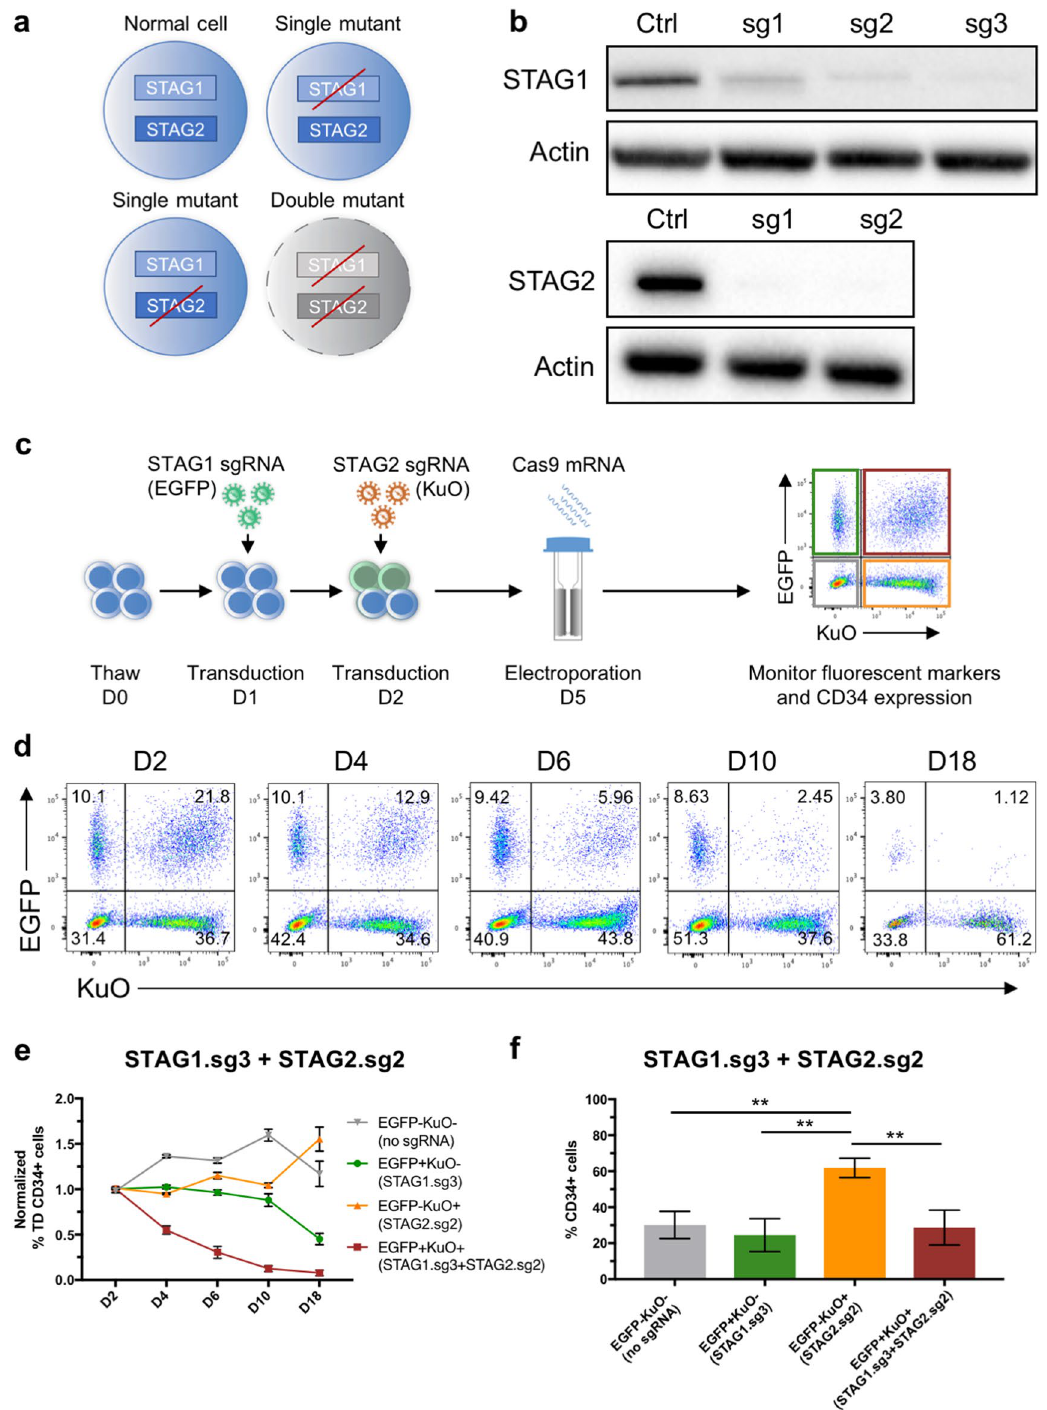
Figure 2. Double gene editing to model the synthetic lethality of STAG1 and STAG2 in primary CD34 + HSPCs. ( a ) Illustration of the synthetic lethality concept of STAG1 and STAG2. Disruption in one of the two genes is tolerated while disruption of both genes is lethal to the cell. ( b ) Western blot analysis of STAG1 and STAG2 proteins in untreated Cas9-expressing HL60 cells (Ctrl) and Cas9- expressing HL60 cells 4 days post-transduction with lentiviral sgRNAs targeting STAG1(sg1, sg2, sg3) or STAG2 (sg1, sg2). STAG1 and actin bands, and STAG2 and actin bands, were cropped from different parts of the same blot, respectively. Original blots are shown in Supplementary Figure S4. ( c ) Overview of experimental outline to target STAG1 and STAG2 in primary HSPCs. Thawed CD34 + cells were sequentially transduced on day 1 and day 2 with lentiviral sgRNAs targeting STAG1 and STAG2, containing EGFP or KuO, respectively. Cells were electroporated with Cas9 mRNA after 3 days in culture and flow cytometry was used to analyse fluorescent marker and CD34 expression (n = 3). ( d ) Representative FACS plots of the transduction efficiency in CD34 + cells for sgRNA combination STAG1.sg3 (EGFP) and STAG2.sg2 (KuO) at day 2–18 (D2–18) post-electroporation. ( e ) Normalized frequency of transduced (TD) CD34 + cells at day 2–18 (D2–18) post-electroporation for sgRNA combination STAG1.sg3 and STAG2.sg2. ( f ) Frequency of CD34 + cells in transduced populations at day 18 post-electroporation for sgRNA combination STAG1.sg3 and STAG2. sg2. Statistical significance was calculated using One-Way ANOVA with Tukey’s multiple comparisons test. **p <